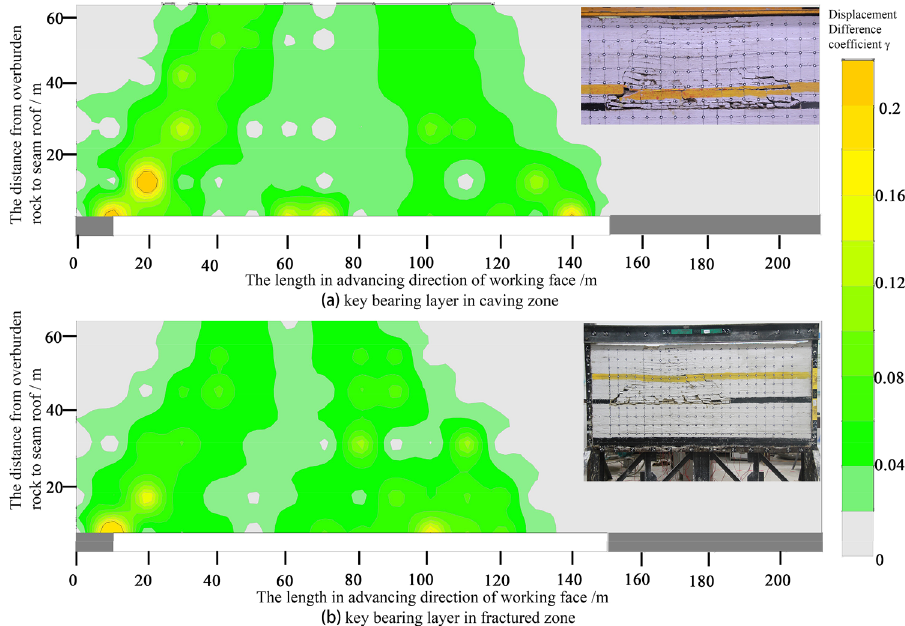
Figure 10. Contours of displacement difference coefficient γ after movement in shallow thick seam